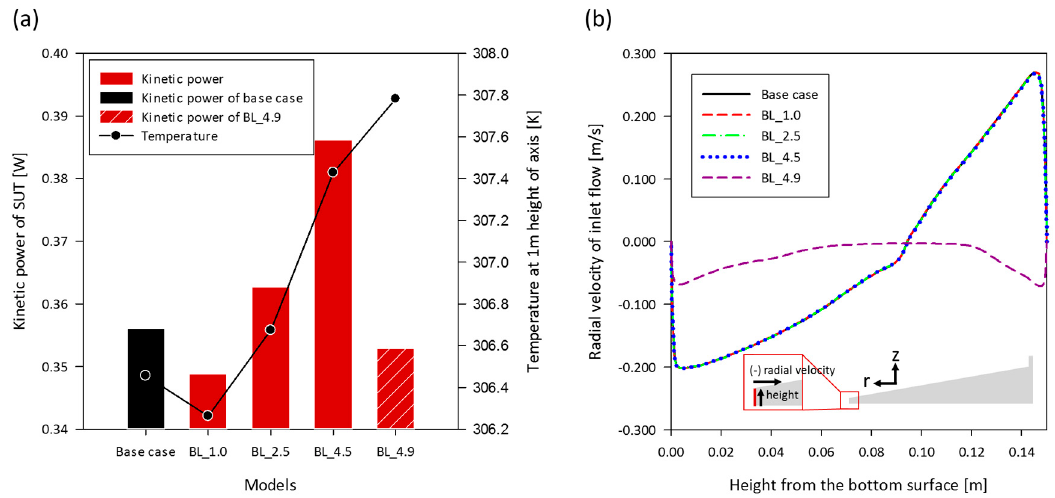
Figure 9. ( a ) The kinetic power and temperature at the height of 1 m from the center axis (denotes “Base case”, “BL_1.0”, “BL_2.5”, “BL_4.5”, and “BL_4.9”’ for comparison) and ( b ) the radial velocity profile at the inlet (denotes “Base case”, “BL_1.0”, “BL_2.5”, “BL_4.5”, and “BL_4.9” for comparison).